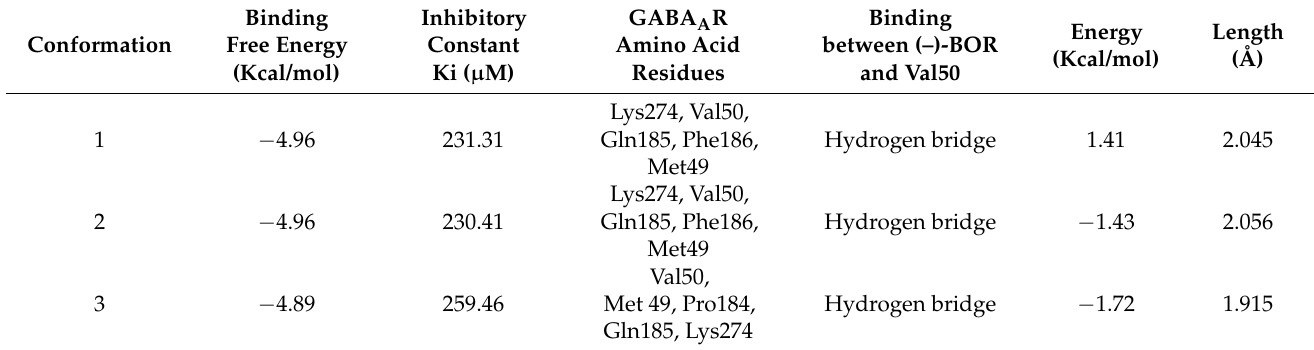
Figure 6. Energy diagram correlated with the conformation obtained at the end of functional density calculation. The conformation chosen was one that presented the lowest energetic state. Table 1. Comparative data of the three best conformations between (–)-BOR and GABA A R.